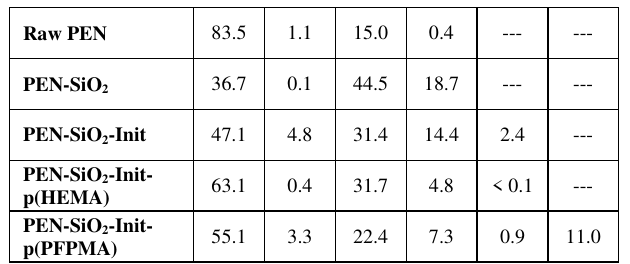
Table 1: Surface elemental compositions as determined by XPS.